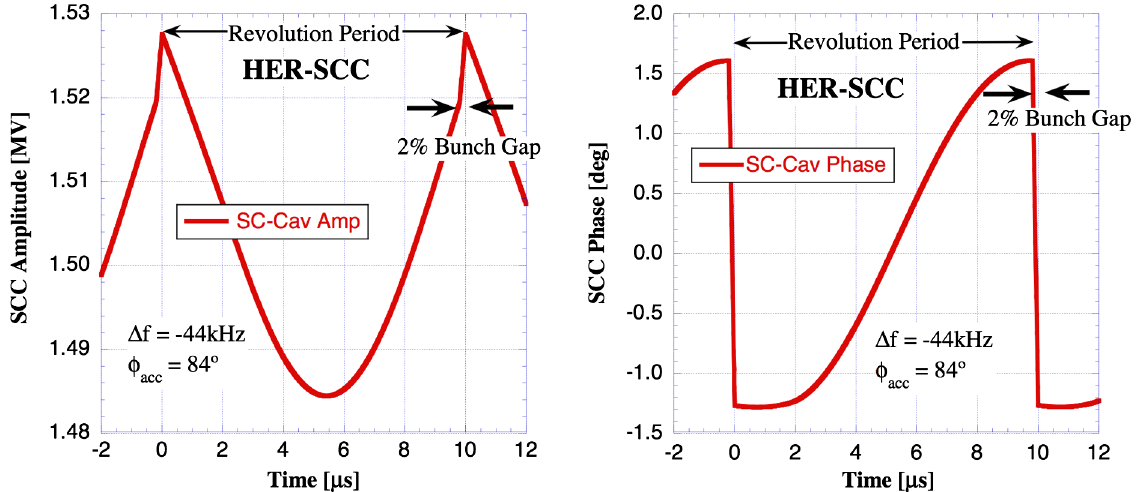
FIG. 10. SCC voltage (amplitude and phase) modulation simulated for HER in